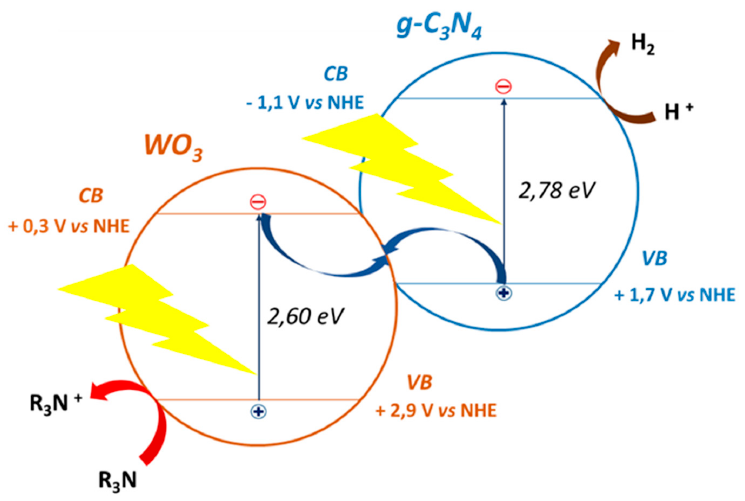
Figure 6. Z ‐ scheme of visible light harvesting g ‐ C 3 N 4 /WO 3 nano ‐ composite. CB and VB energy levels Figure 6. Z-scheme of visible light harvesting g-C 3 N 4 /WO 3 nano-composite. CB and VB energy levels have been taken from [213]. have been taken from